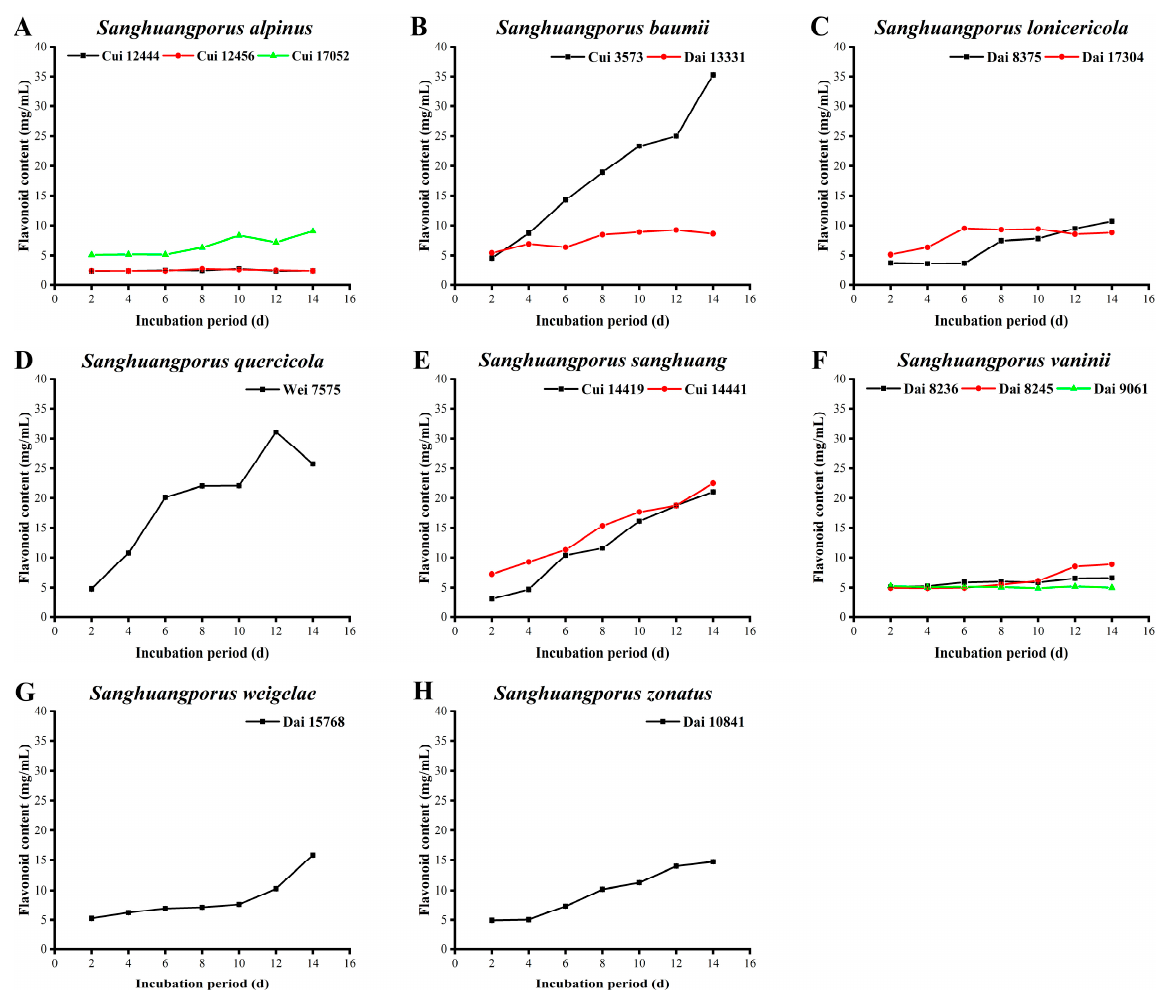
Figure 4. Variations in flavonoid contents during submerged fermentation of 15 wild strains from 8